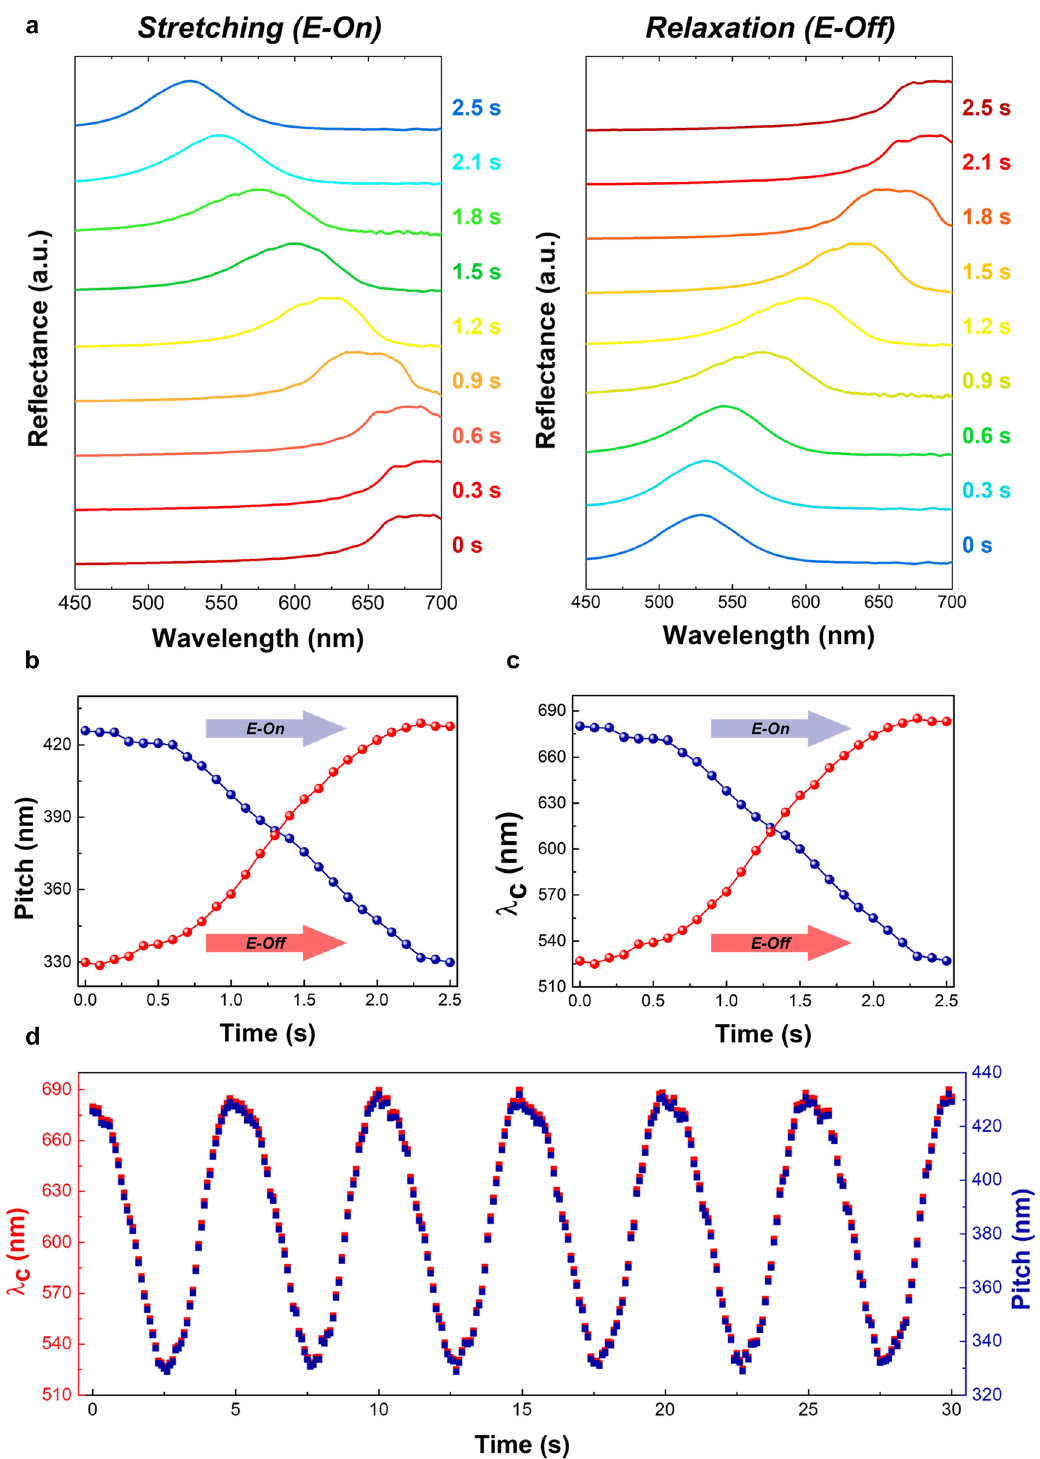
Figure 5: Time-tracked electro-mechano-optical wavelength changes in the properties of CPGs: (a) evolutional photonic wavelength shifts of electrically stretchable CPGs in a state between applying (E-On, stretching) and removing (E-Off, relaxation) an electric field of 45 V/ μ m at a 0.2Hzsinewavesignalingcondition;(b)symmetricalreversibleswitchingofthecentralphotonicwavelength( λ c )position;(c)reversiblechiral pitch-length changes between E-On (stretching) and E-Off (relaxation) of a 45 V/ μ m electric fi eld at a 0.2 Hz sine wave; (d) time-based monitoring of electrically stretchable CPG switching in terms of central photonic wavelength ( λ c ) position tracking and tuned pitch length ( p ) during a continuously applied electric fi eld of 45 V/ μ m at a 0.2 Hz sine wave for up to 30